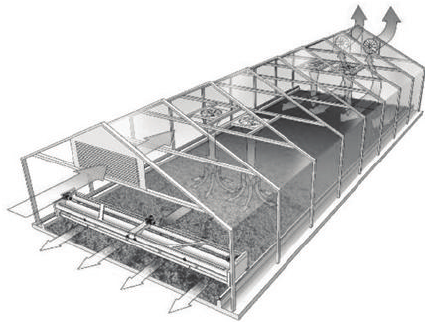
Figure 3: Scheme of solar drying plant with nave turning sludge device